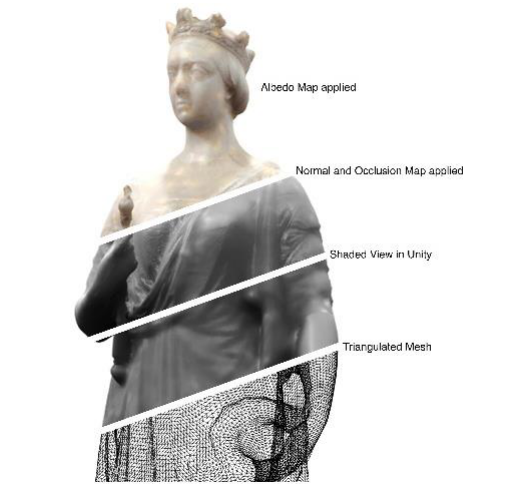
Figure 11. Photogrammetric mesh of a heritage statue with texture layers visible.